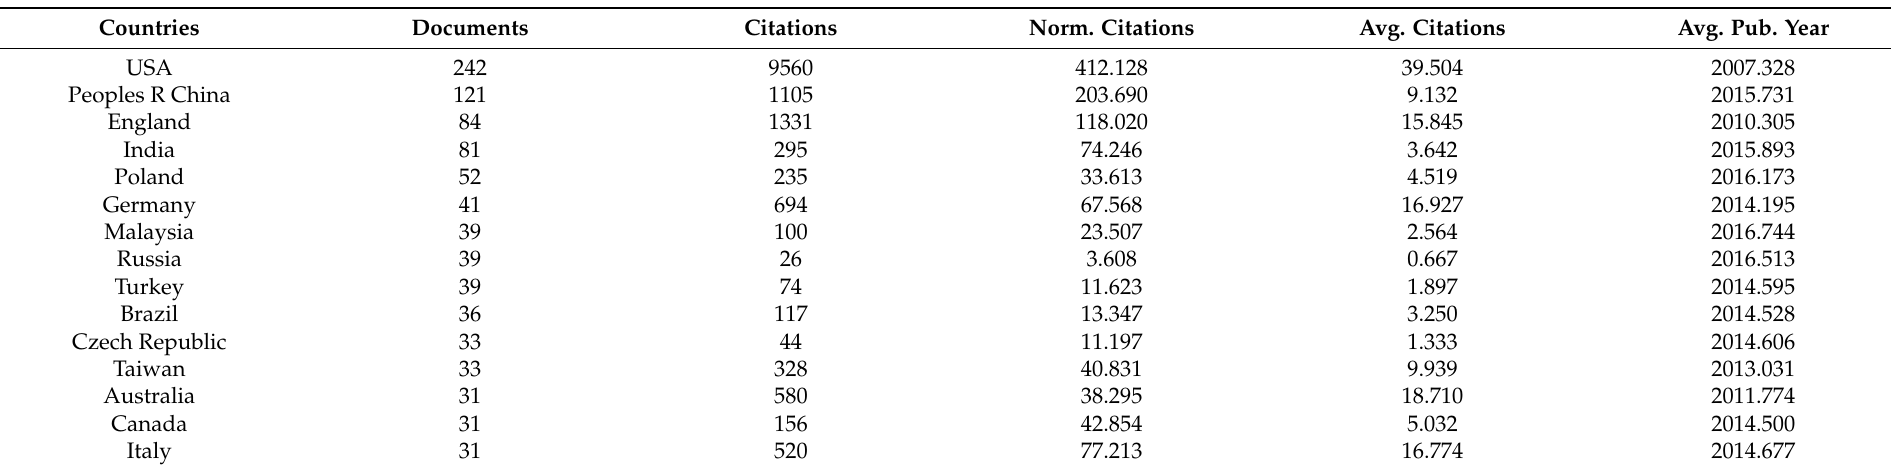
Table 7. Co-authorship links and top 15 (documents) countries items, considering 1 as the minimum number of documents of a country.